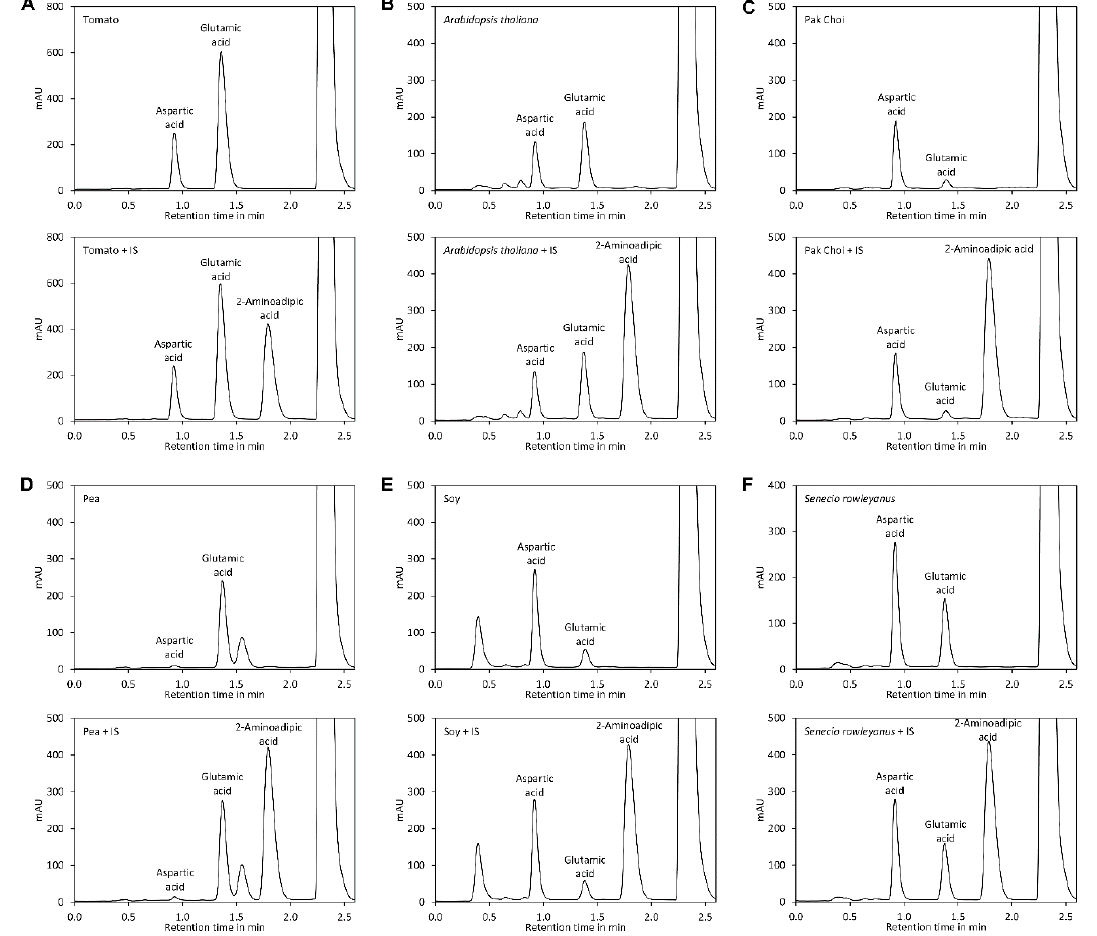
Figure 2. 2-Aminoadipic acid is not present in plant samples. ( A ) Chromatogram of a tomato extract (5 µL tomato extract were derivatised in a reaction with a total volume of 120 µL) derivatised with DNFB and analysed by UHPLC with a flow rate of 1 mL/min. The sample in the upper panel was not spiked, the sample in the lower panel was spiked with 10 µL of 2-aminoadipic acid 1000 mg/L. All other samples were treated in the same way and analysed without spike (upper panels) and spiked with 10 µL of 2-aminoadipic acid 1000 mg/L (lower panels). ( B ) Sap of Arabidopsis thaliana leaves (30 µL). ( C ) Sap of pak choi petioles (30 µL). ( D ) Sap of unripe peas (2 µL). ( E ) Sap of soy leaves (20 µL).